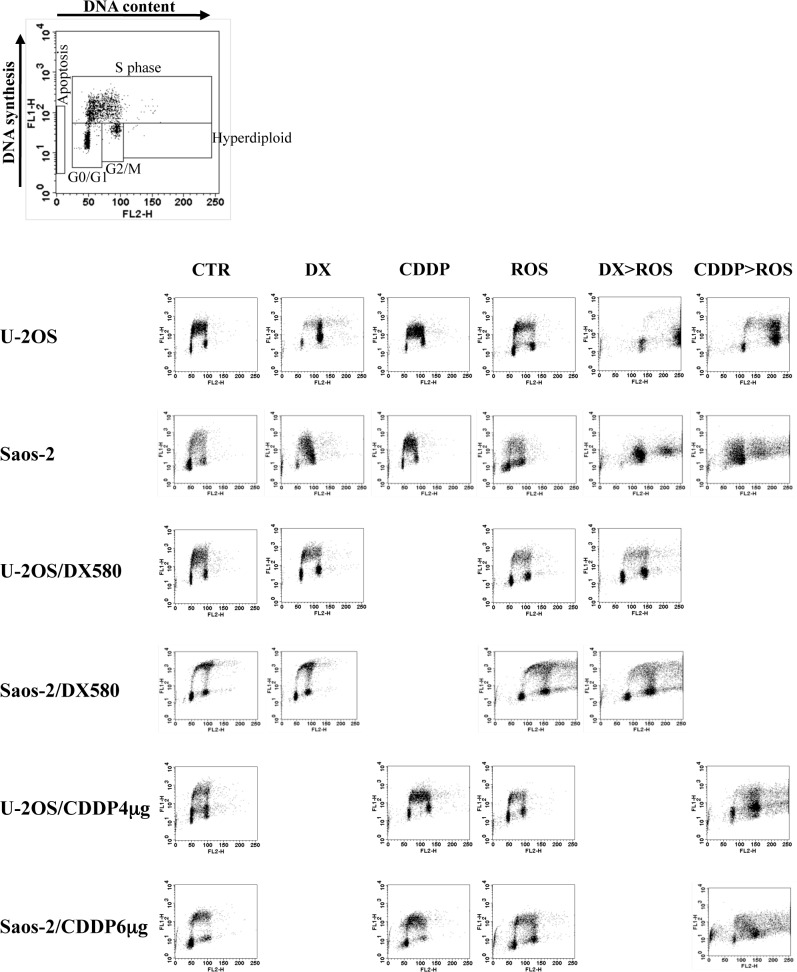
Effects on cell cycle of doxorubicin (DX), cisplatin (CDDP) and roscovitine (ROS), used either alone or in combination, in the human osteosarcoma cell lines U-2OS and Saos-2 and their variants resistant to DX or CDDP. Cell cycle phase distribution was determined by flow cytometry after bromodeoxyuridine (BrdU) incorporation and propidium iodide counterstaining. The intensity of propidium iodide fluorescence (representative for the DNA content) was plotted on the X axis. The intensity of the incorporated BrdU fluorescence (representative for the DNA synthesis) was plotted on the Y axis. Legend: CTR, control cells cultured in drug-free medium; DX, CDDP, ROS, cells treated with their respective IC50 dosages of each drug for 24 h (DX and CDDP) or 48 h (ROS); DX>ROS and CDDP>ROS, cells sequentially treated with their respective IC50 dosages of DX or CDDP for 24 h followed by treatment with the IC50 concentration of ROS for 48 h.